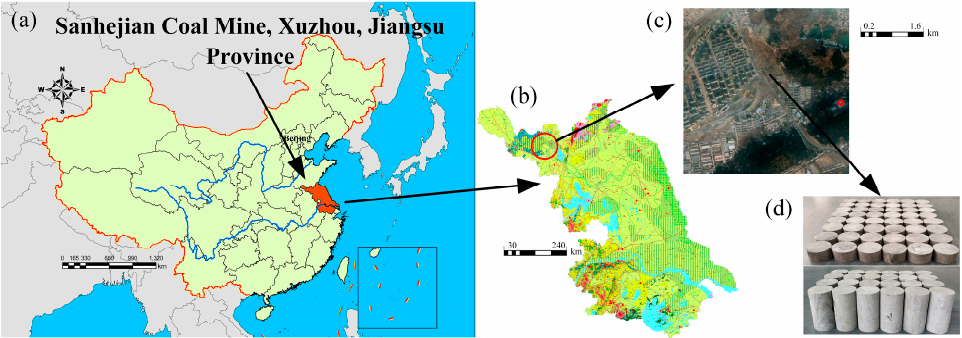
Figure 2. Coal measures sandstone sampling sites: ( a ) Location in China; ( b ) geological sketch of Jiangsu province (from the National Geological Archive of China); ( c ) satellite view of the Sanhejian coal mine; ( d ) part of sandstone specimens.